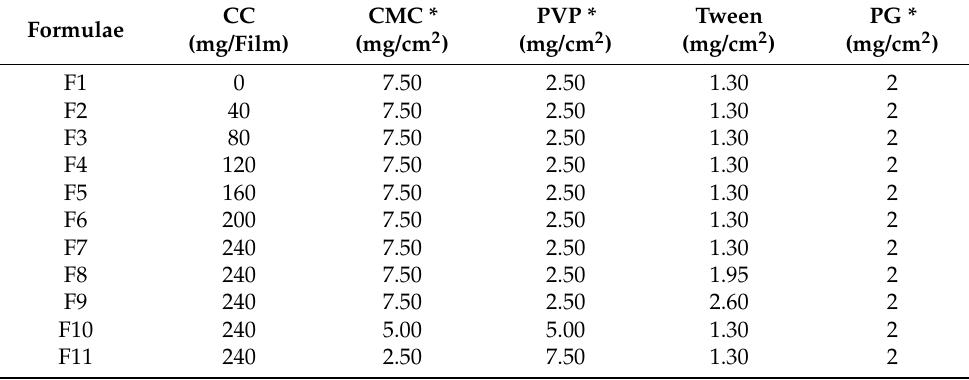
Table 1. Composition of different CC buccal muco-adhesive